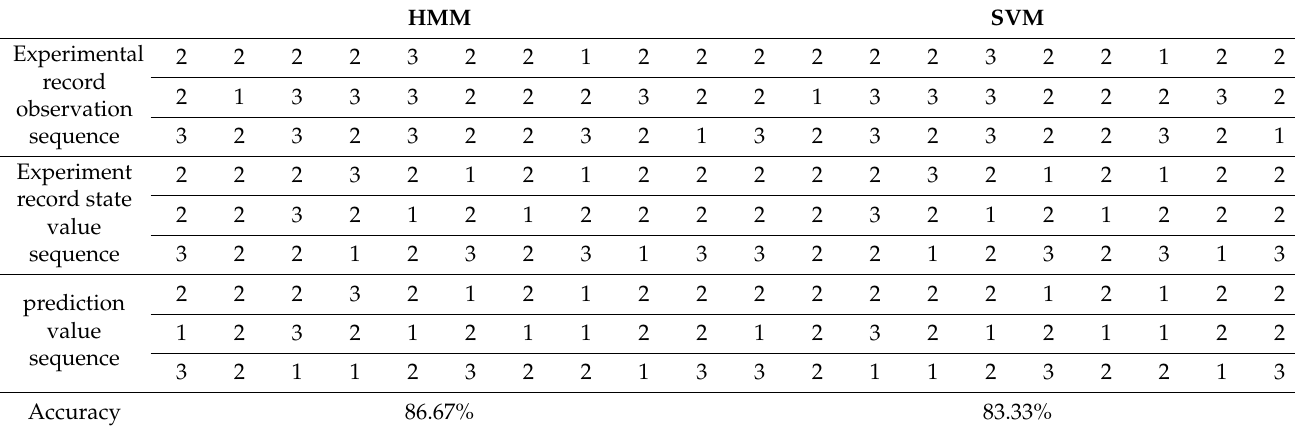
Table 4. Results of contrast between hidden Markov model and support vector